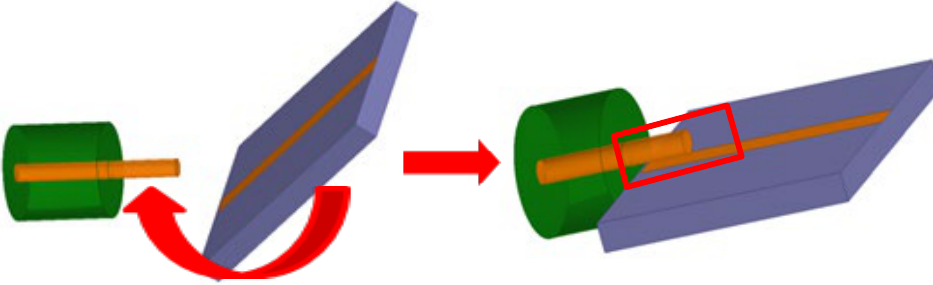
Figure 9. Diagrammatic sketch of assembly blocks.